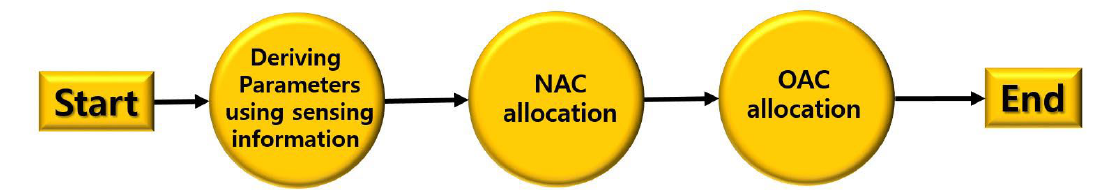
Figure 6. The procedures of EMRRA.